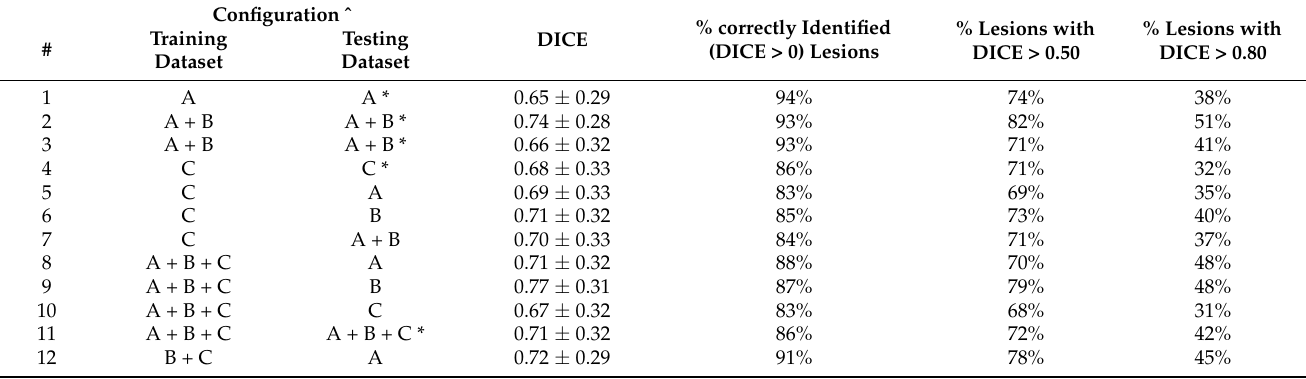
Table 2. Results of segmentation, before post-processing and including only the outputs with a DICE > 0. DICE is intended as mean ± standard deviation. The last three columns correspond to the number of lesions with a DICE > 0, DICE > 0.5 and DICE > 0.80, respectively, across the total number of test